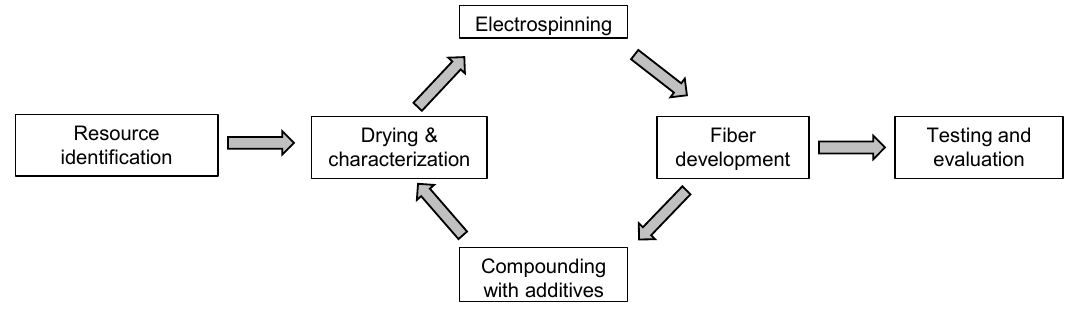
Figure 4. Overview of the experimental workflow.